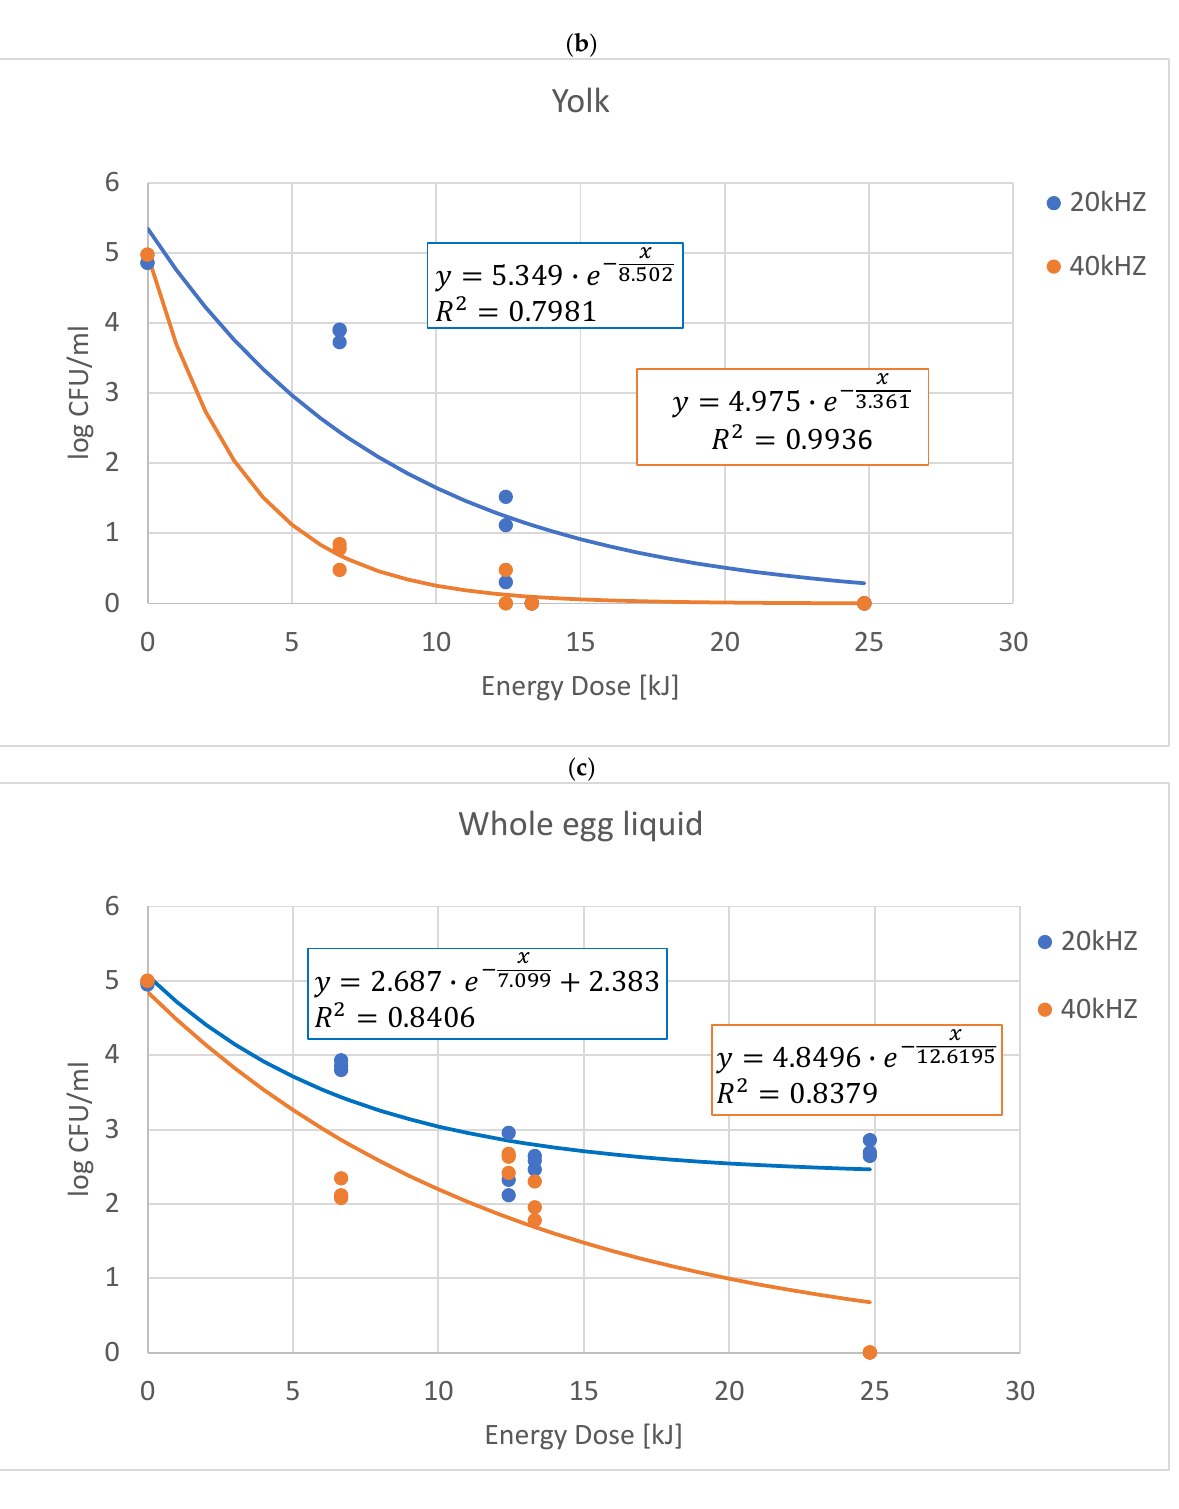
Figure 2. Regression of concentration (y) by the energy dose (x) of the treatment for 20 kHz and 40 kHz ( a ) albumen, ( b ) yolk, ( c ) liquid egg.